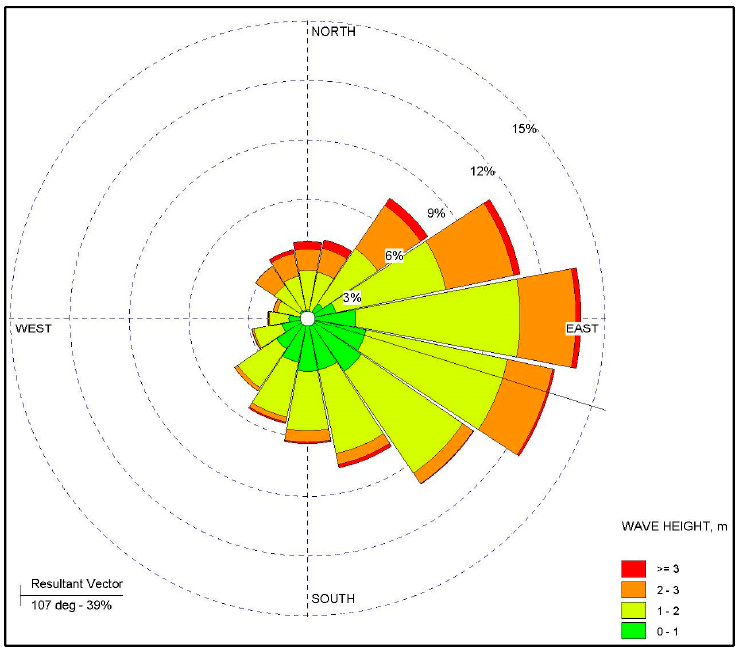
Figure 7. Wave rose for Station 63460 off the coast of Palm Beach County.